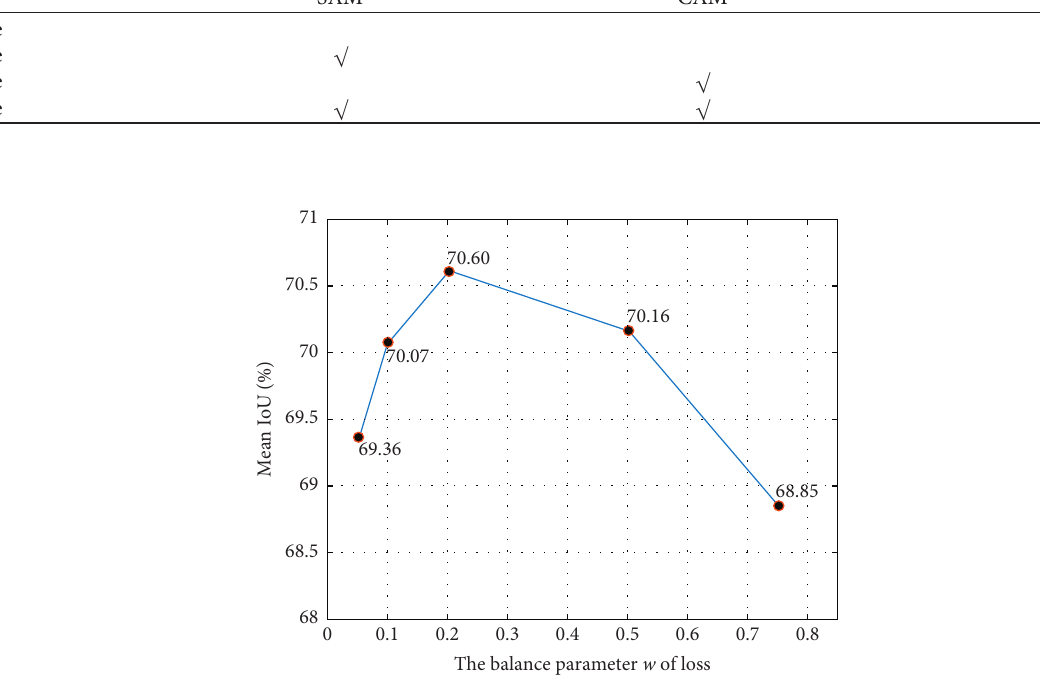
Figure 6: Performance of proposed network with different ω value.